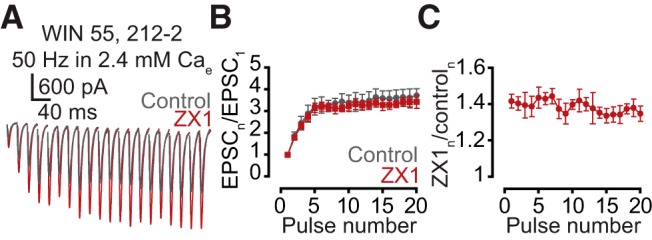
The postsynaptic inhibitory effect of zinc on AMPA EPSC does not contribute to the zinc-mediated enhancement of synaptic facilitation. A, Representative traces of AMPA EPSCs, evoked by 50-Hz 20-pulse train in the presence of 50 nm WIN 55 212-2, before (gray) and after (maroon) ZX1. B, Summary graph showing average AMPA EPSC amplitudes during the train, normalized to EPSC amplitude elicited by the first pulse, before (gray) and after (maroon) ZX1 (ratio of the amplitude of 16–20 EPSC to first EPSC at 50 Hz: control vs. ZX1, n = 5, p = 0.18). C, Summary graph showing average ratios of AMPA EPSCs in the presence of ZX1 to that in control during the train (ZX1–2/control1–2 vs. ZX16–20/control16–20,
n = 5, p = 0.23). Values represent mean ± SEM. Detailed values and statistical tests: B, Ratio of the amplitude of 16–20 EPSC to first EPSC at 50 Hz: control: 3.63 ± 0.35 vs. ZX1: 3.23 ± 0.22, n = 5, p = 0.18, F = 1.84, DFn = 1, DFd = 40; two-way ANOVA; C, ZX1–2/control1–2 vs. ZX16–20/control16–20: 1.40 ± 0.04 vs. 1.35 ± 0.05, n = 5, p = 0.23, t = 1.39, df = 4, paired t-test.